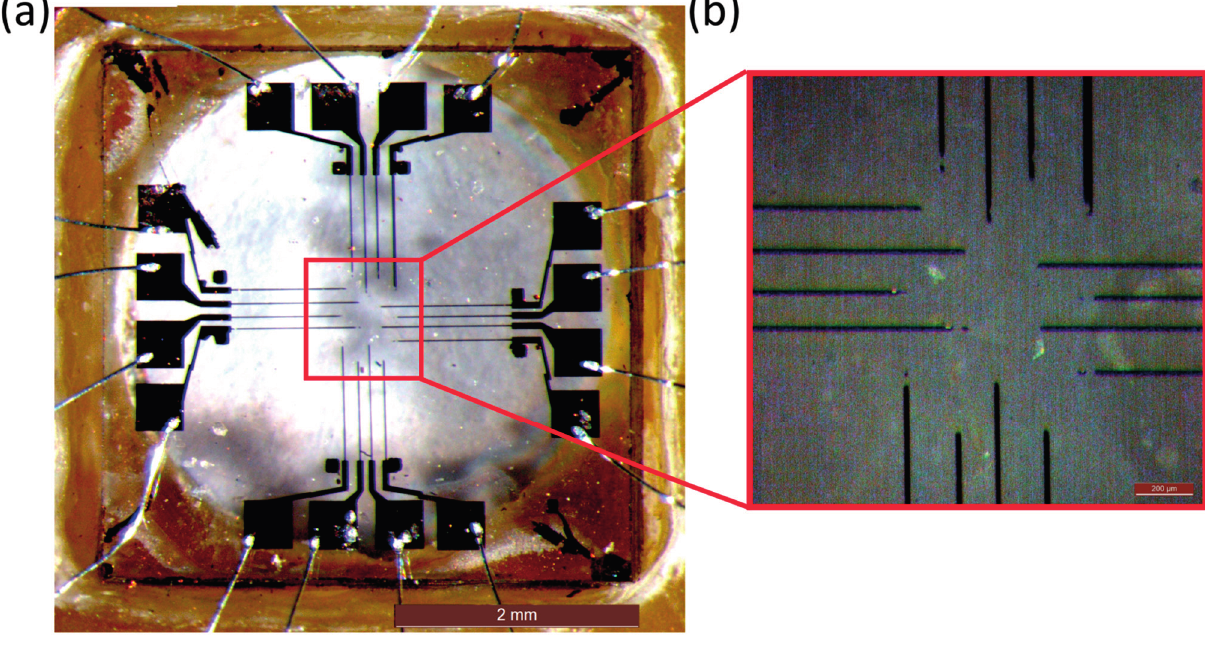
Figure 2. ( a ) Top-view optical micrograph of the diamond-based biosensor: the 16 graphitic channels are ~20 µm wide, ~1 mm long, ~250 nm thick, with sensing areas of ~20 × 5 µm 2 . The diamond substrate is mounted and wire-bonded on the chip carrier; ( b ) zoom optical micrograph of the central part of the